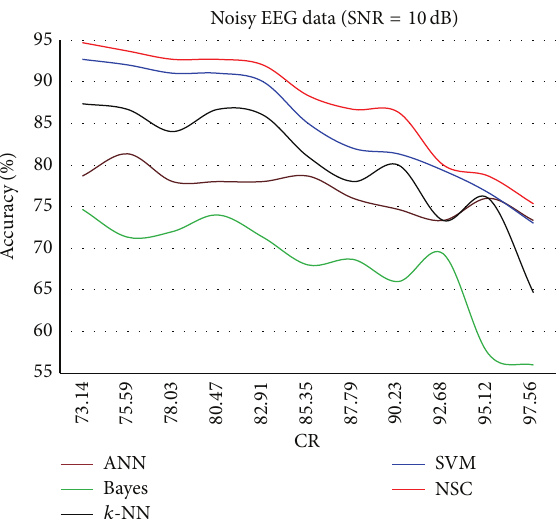
Figure 7: Classification accuracy against CR for SNR = 10dB.